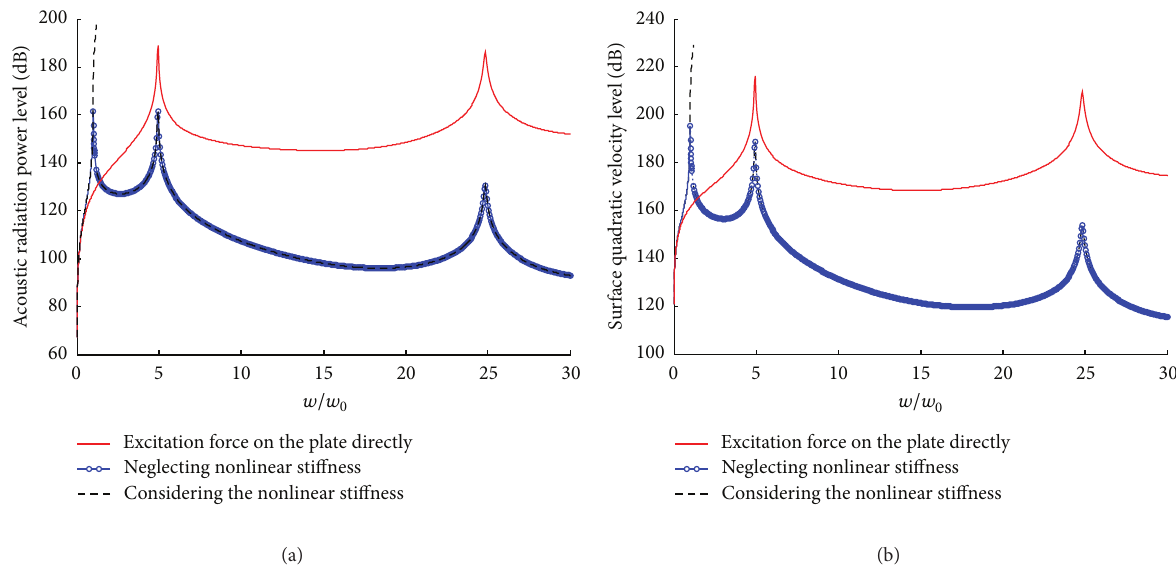
Figure 2: Influence of the supporting form on the vibration properties of the oscillator: (a) acoustic radiation power level and (b) surface quadratic velocity